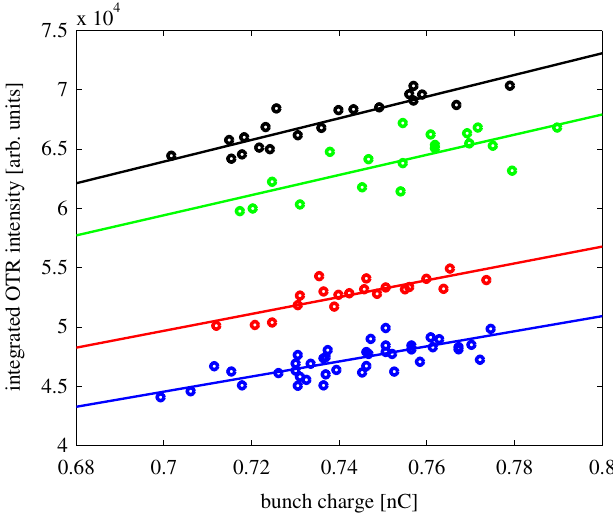
FIG. 4. (Color) Shot-to-shot fluctuations of the integrated OTR intensity at the screen OTR1 and of the bunch charge under FEL operating conditions ( E ¼ 494 MeV ). The different colors refer to different gains of the CCD camera which were chosen to avoid CCD saturation. The straight lines pass through the